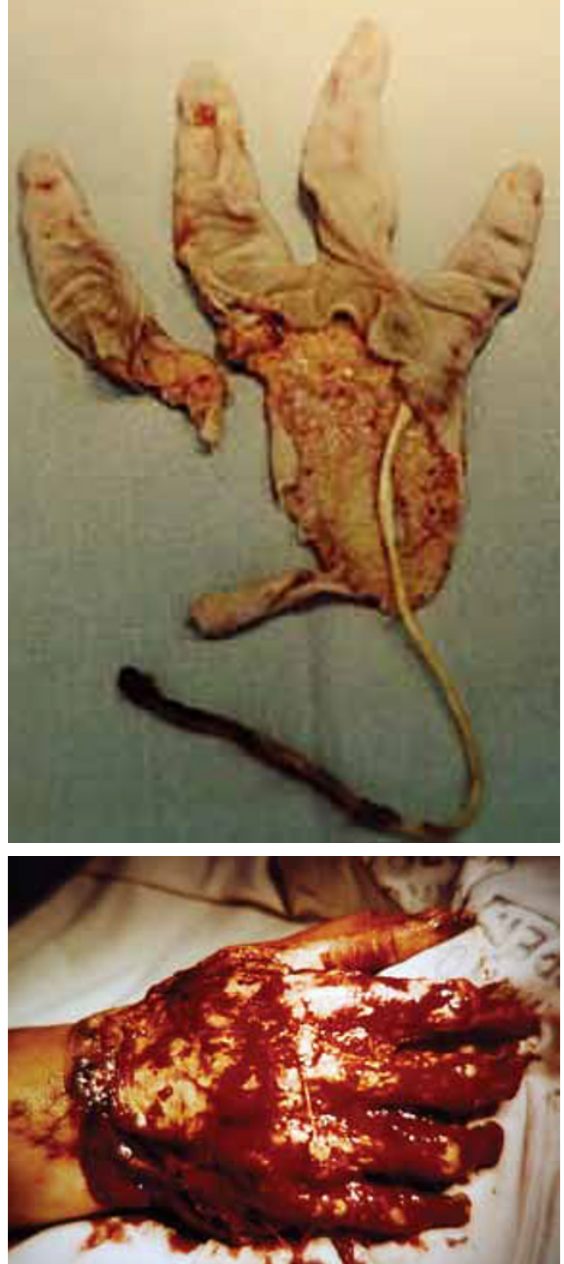
Figure 1. Clinical case 1. A traumatic injury of the right hand – a degloved tissue defect (a). Avulsion of the distal phalanges of the 4th and 5th fi ngers. The thumb is not injured